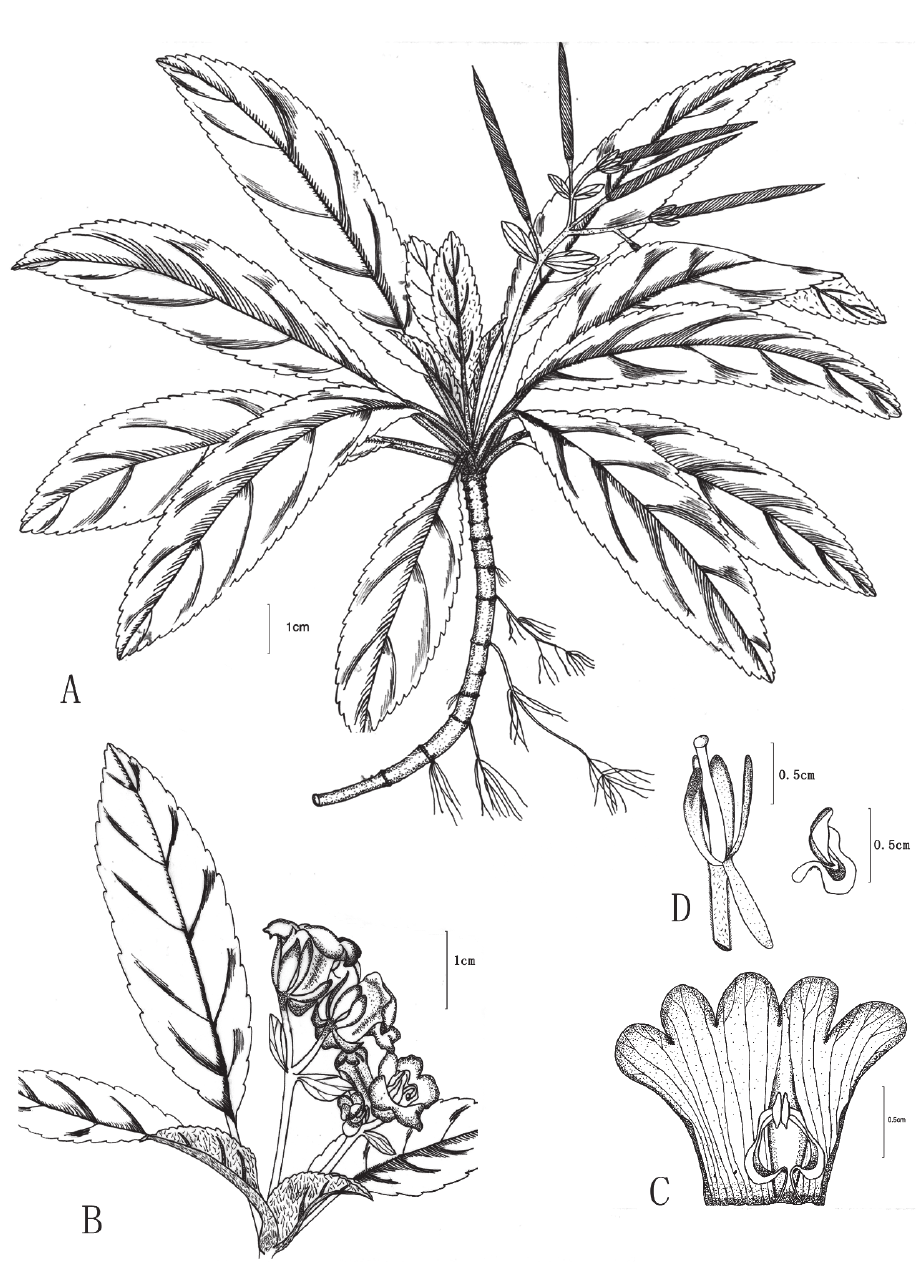
Figure 1. Paraboea wenshanensis X.Hong & F.Wen. A Habitat in fruiting period B Inflorescences C Dis- section of a flower showing corolla, stamens and staminodes D Calyx and pistil, stamen (showing the glandular–puberulous, inflated and strongly